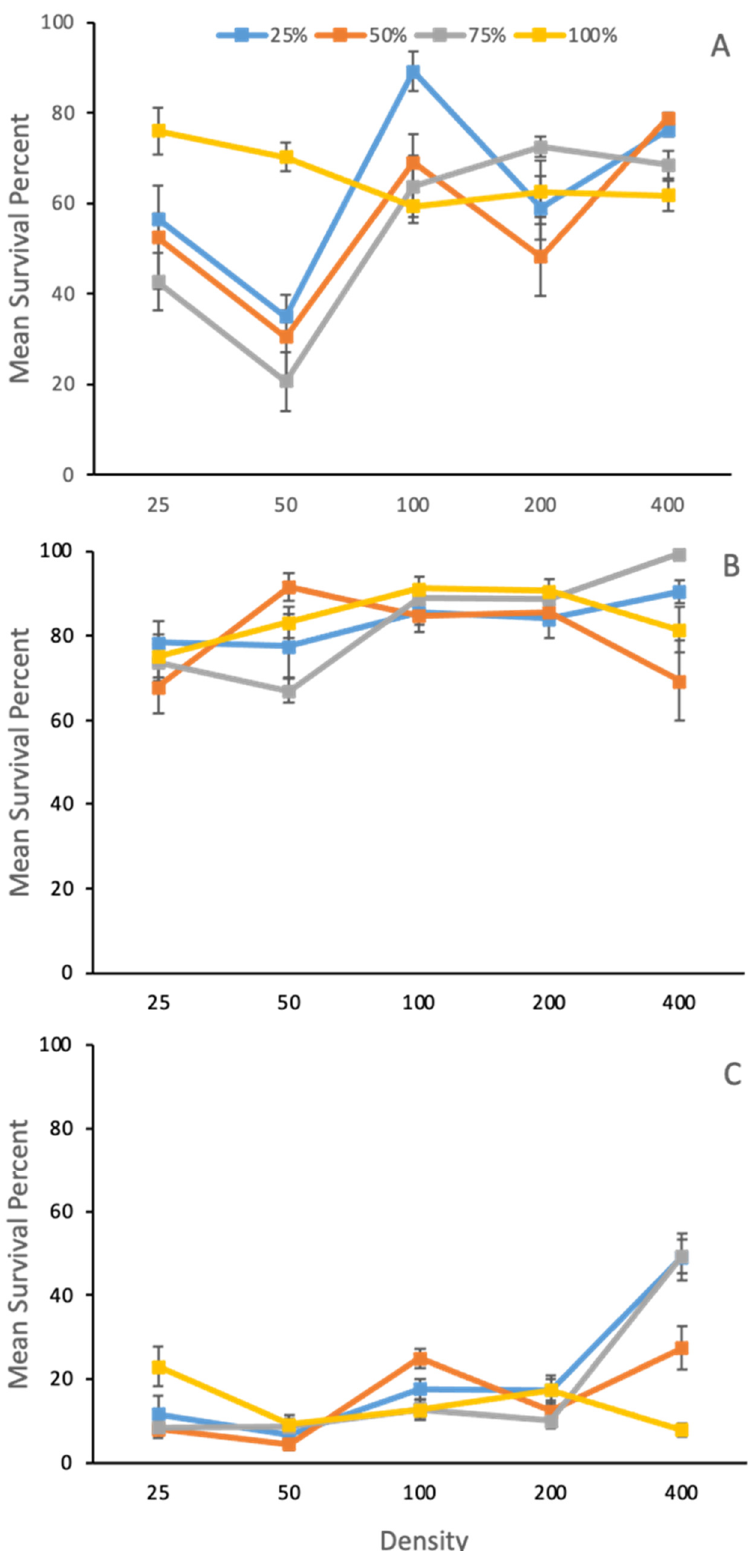
Figure 4. Mean ± SE percent survival to adult of Lucilia sericata Meigen (Diptera: Calliphoridae) reared within larval ratios of 100% L. sericata , 75% L. sericata to 25% Phormia regina Meigen (Diptera: Calliphoridae), equal 50:50 ratio, or 25% L. seriata to 75% P. regina at ( A ) 15 °C, ( B ) 25 °C, and ( C ) 35 °C across densities (larvae/jar). Survival was influenced by an interaction between density and species ratio treatments (F 3,584 = 7.19, p < 0.0001), but not temperature (F 3,584 = 0.77, p = 0.5).